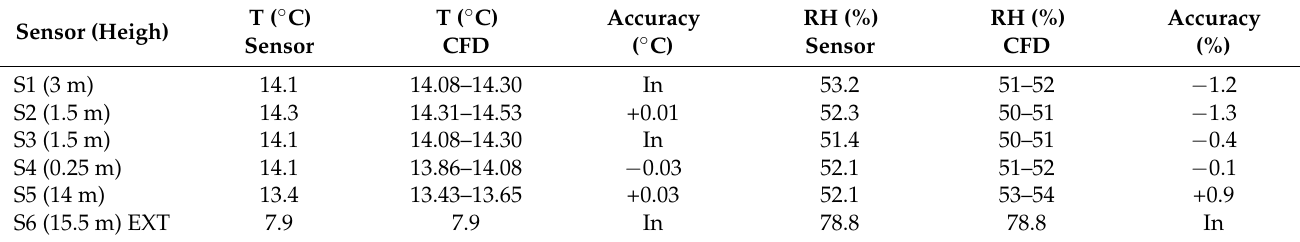
Table 10. Comparison of temperature and relative humidity in the case of